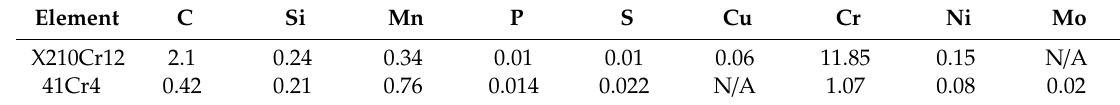
Table 2. Chemical composition of feedstock material.